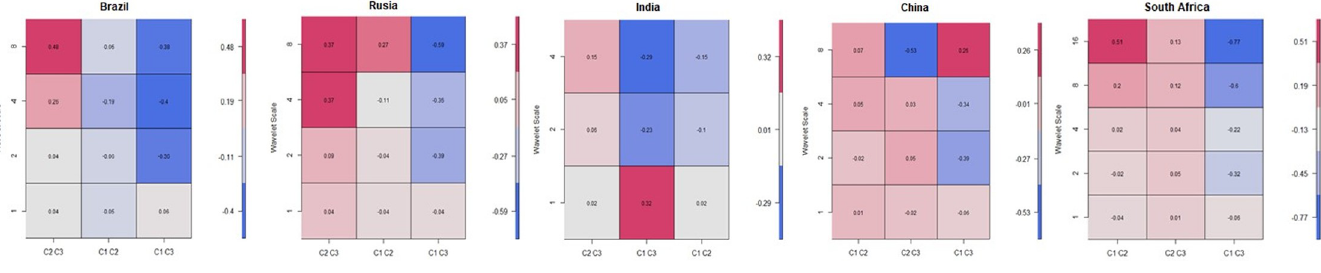
PLOS ONE | https://doi.org/10.1371/journal.pone.0259303 November11,